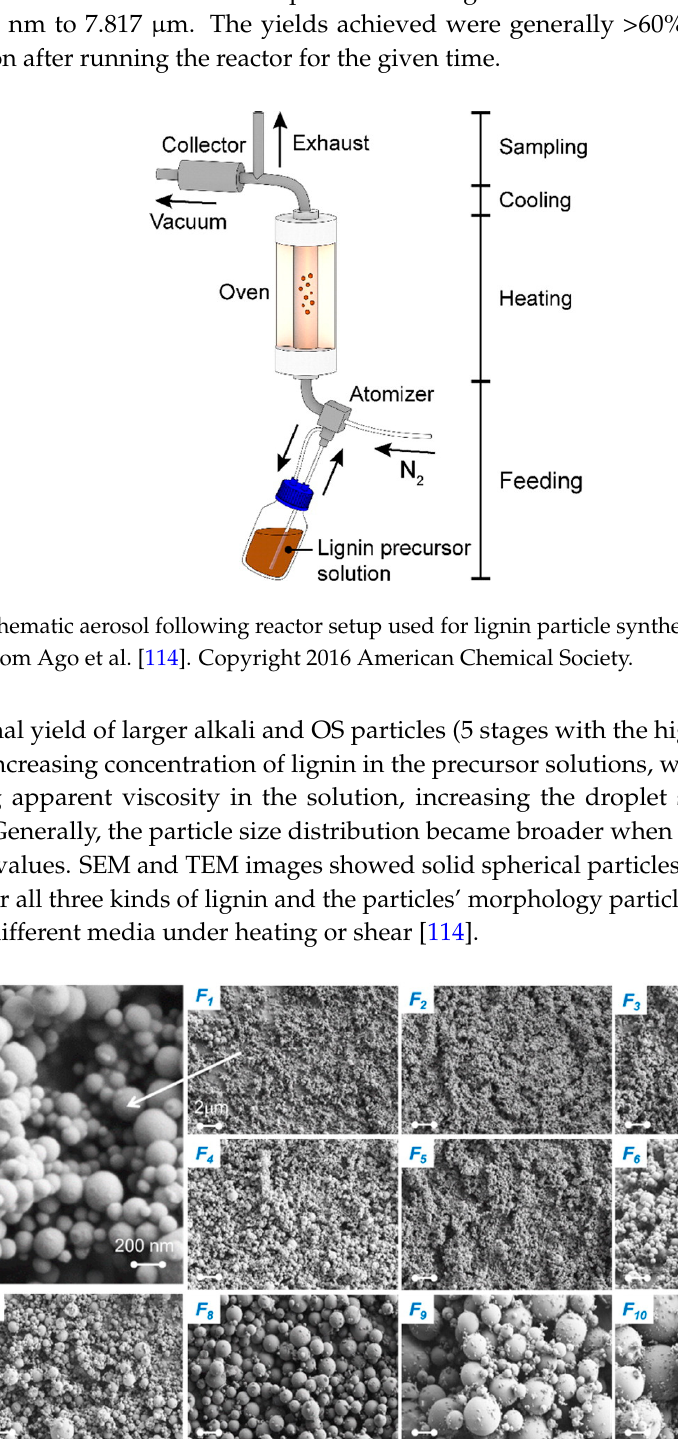
Figure 13. SEM images of different Kraft lignin (KL) particle fractions. F1-10 indicates fraction and the scale bar is 2 µm Reprinted with permission from Ago et al. [114]. Copyright 2016 American Chemical Society.